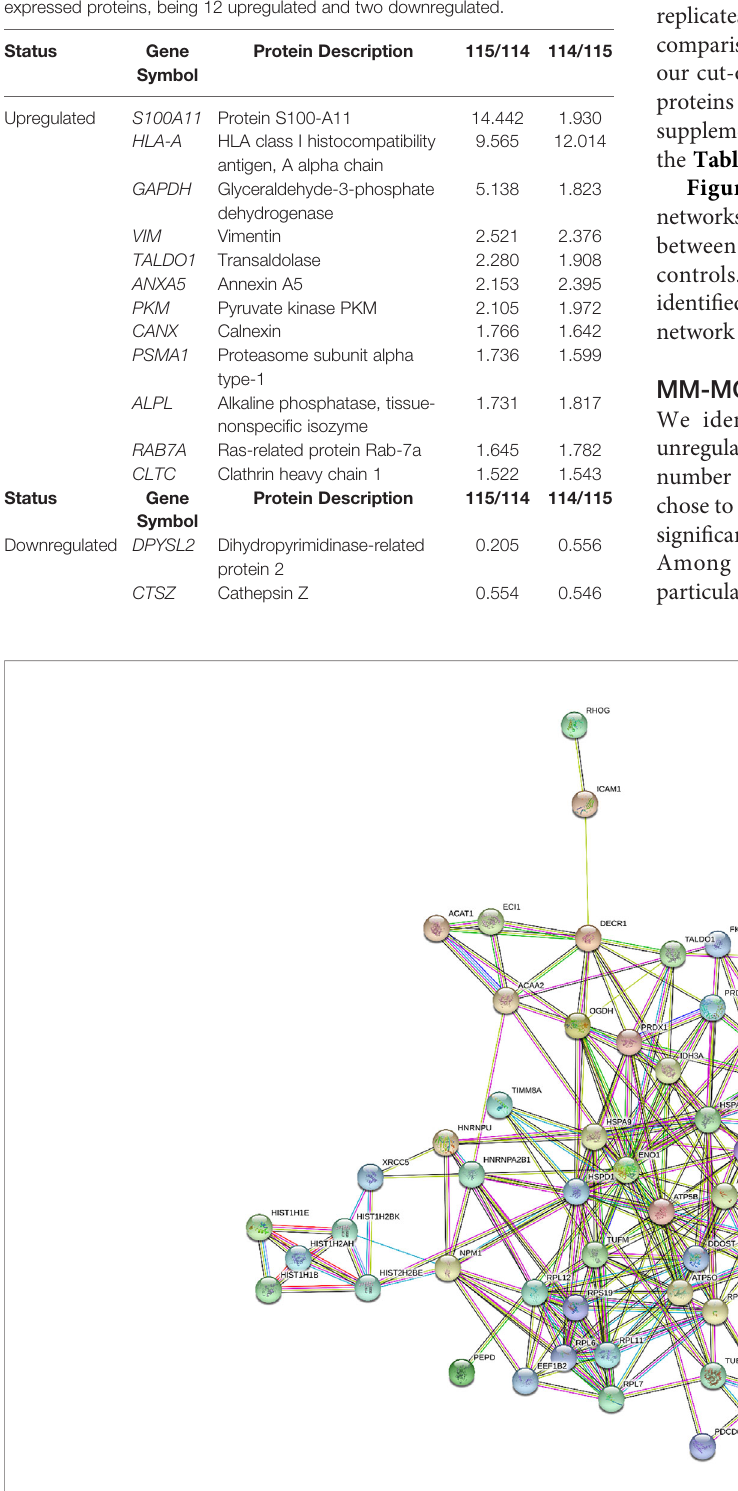
FIGURE 1 | Protein-protein interaction network in MM- MC CD138-CD105- vs. HD-MC CD138-CD105- : upregulated proteins. Nodes represent proteins and edges represent protein-protein associations. Node color: colored nodes and white nodes represent, respectively, query proteins and fi rst shell of interactions, and second shell of interactions. Node content: empty and fi lled nodes represent, respectively proteins of unknown 3D structure, and some 3D structure is known or predicted. The edges are composed of known interactions, predicted interactions, among other forms of interaction, including co-expression. (STRING